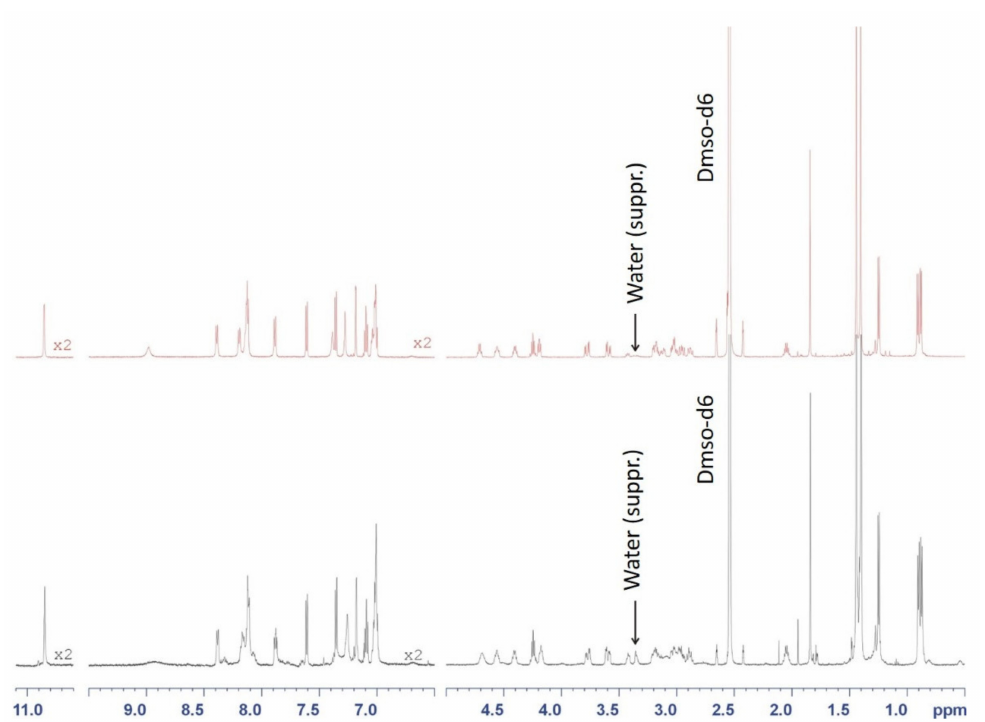
Figure 1. Superposition of the 1H-NMR spectra (dmso-d6, 300K) of compound 6a as obtained from the aziridine precursor (black) and from the cyclic isoserine-sulfamidate precursor (compound 1d in [19]).